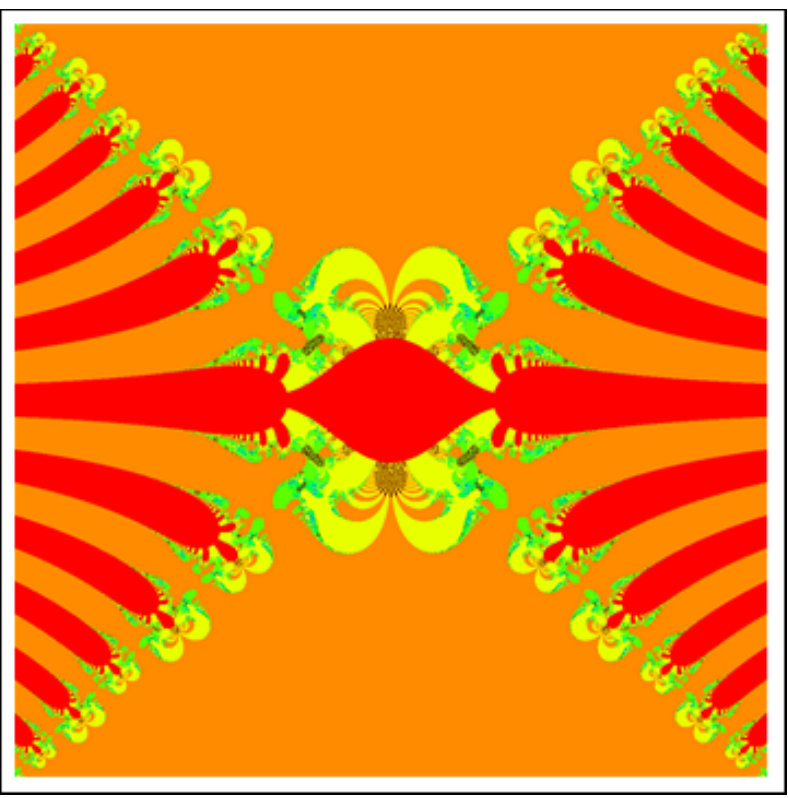
Figure 16. J-set for τ ( z ) = e z 2 + c via DKIS. The image execution time is 138.235 s.